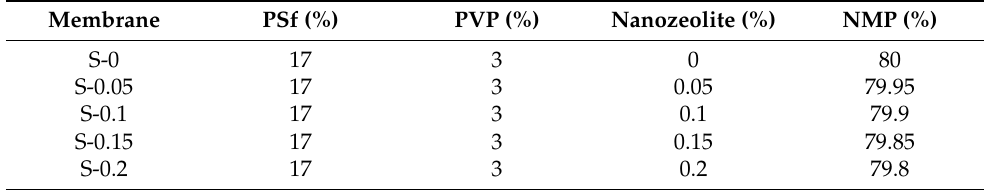
Table 1. Composition of casting solution for all the supports expressed in mass